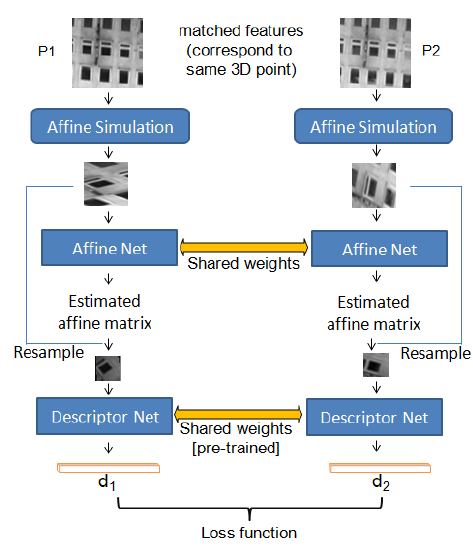
Figure 4. Affine shape estimation architecture. After affine distor- tion of the patches, the affine shape matrix elements are estimated and the patches are resampled. The corrected patches are then introduced to the pre-trained descriptor network to obtain